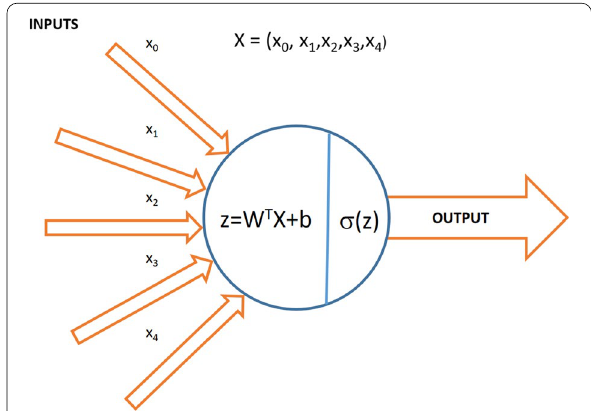
Fig. 5 Structure of a single neuron in an artificial neural network